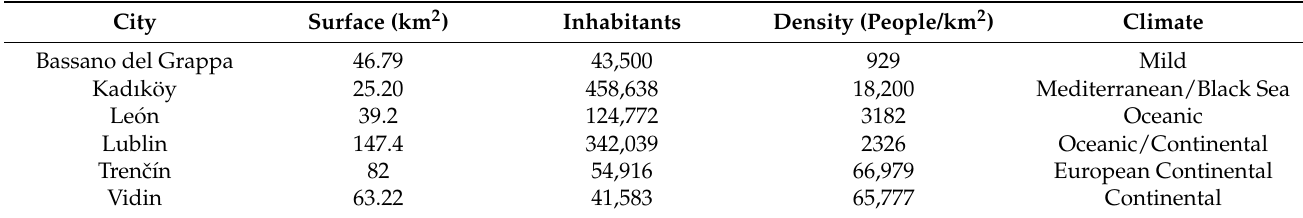
Table 14. Main characteristics of the cities.